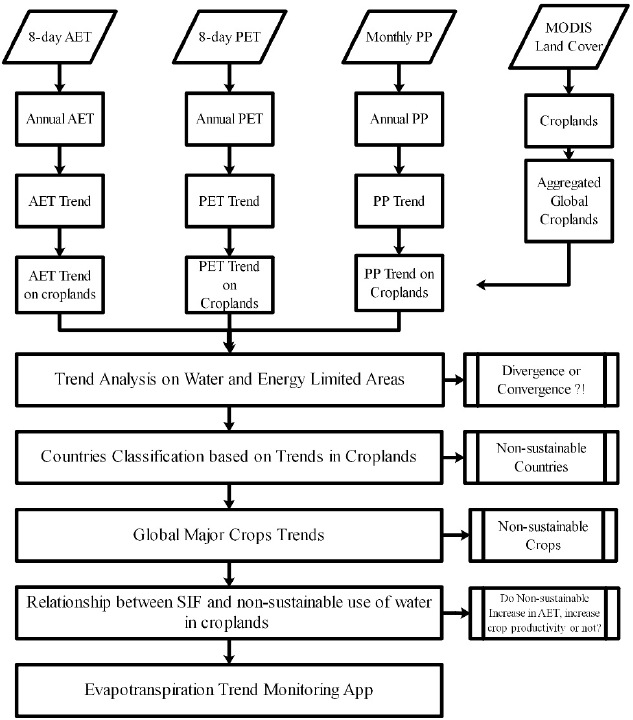
Figure 1. The workflow of the study. AET: actual evapotranspiration, PET: potential ET, and PP: precipitation rate.